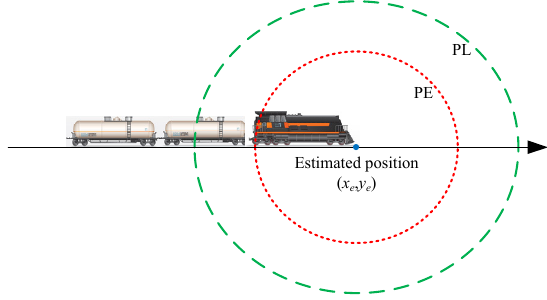
Figure 3. PE and PL in the GNSS-based train positioning.